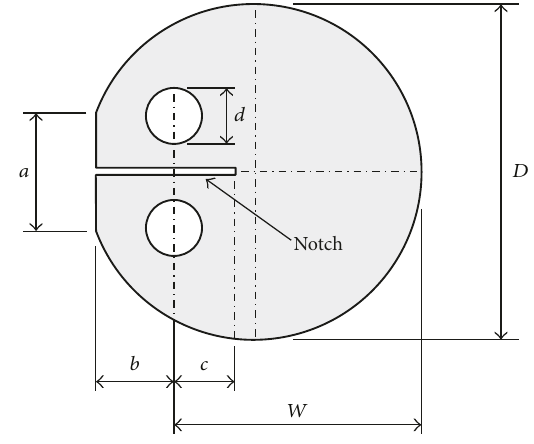
Figure 2: DCT specimen geometry.